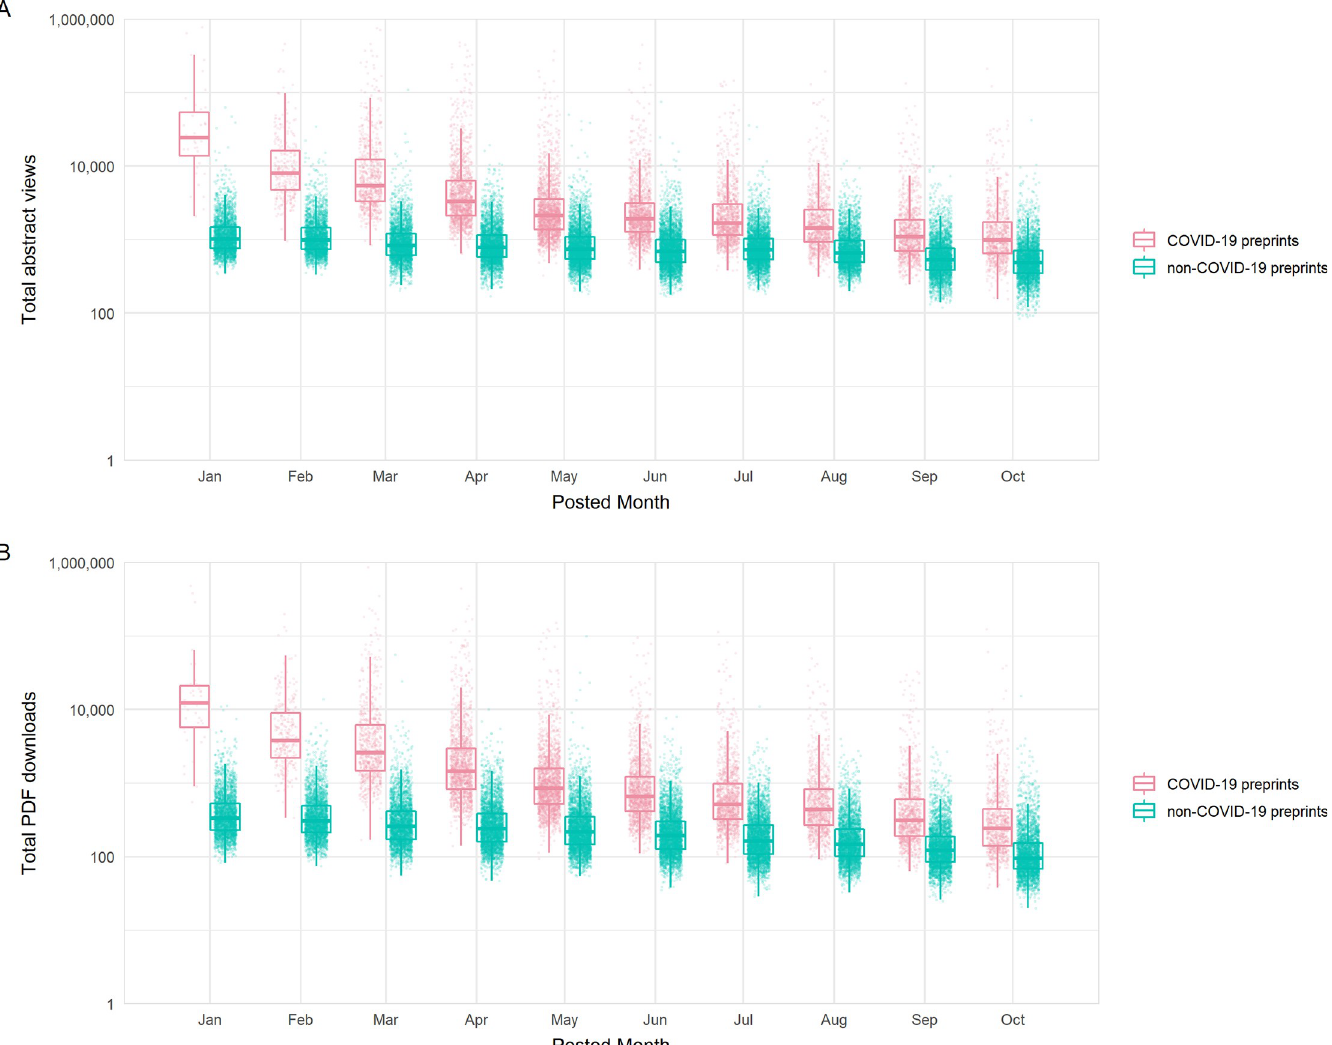
Fig 5. Access statistics for COVID-19 and non-COVID-19 preprints posted on bioRxiv and medRxiv. (A) Boxplots of abstract views, binned by preprint posting month. (B) Boxplots of PDF downloads, binned by preprint posting month. Boxplot horizontal lines denote lower quartile, median, upper quartile, with whiskers extending to 1.5 � IQR. All boxplots additionally show raw data values for individual preprints with added horizontal jitter for visibility. The data underlying this figure may be found in https://github.com/preprinting-a-pandemic/pandemic_preprints and https://zenodo.org/record/4587214#.YEN22Hmnx9A. COVID-19, Coronavirus Disease